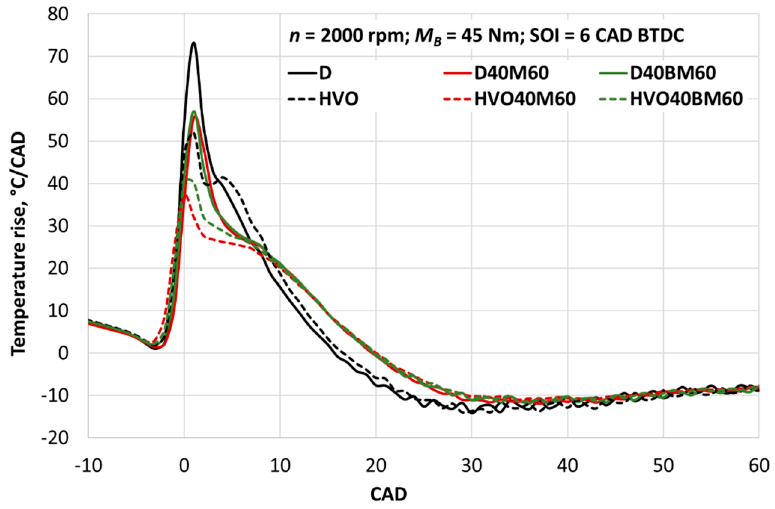
Figure 12. Temperature rise in the cylinder depending on fuel composition. Appl. Sci. 2020 , 10 , x FOR PEER REVIEW